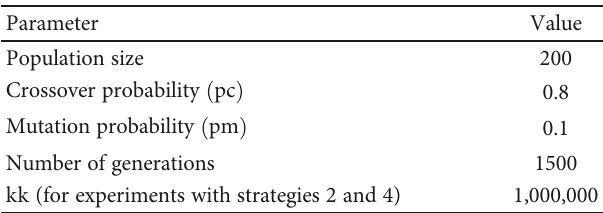
Table 21: Genetic algorithm parameters for all experiments.